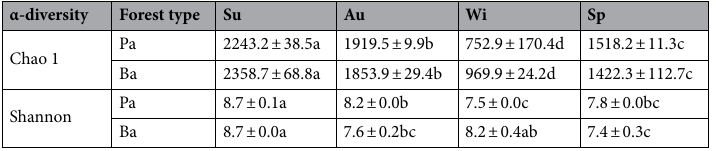
Table 2. Mean α-diversities of the bacterial communities in different seasons. Different letters stand for significant differences at the 0.05 level. Sp, Su, Au and Wi represent spring, summer, autumn, and winter, respectively. Pa: Picea asperata Mast.; Ba: Betula albosinensis (data in this table is analyzed by Mothur, version 1.30.1, 2013, University of Michigan, Ann Arbor, MI, USA; software available at: https ://mothu r.org/).